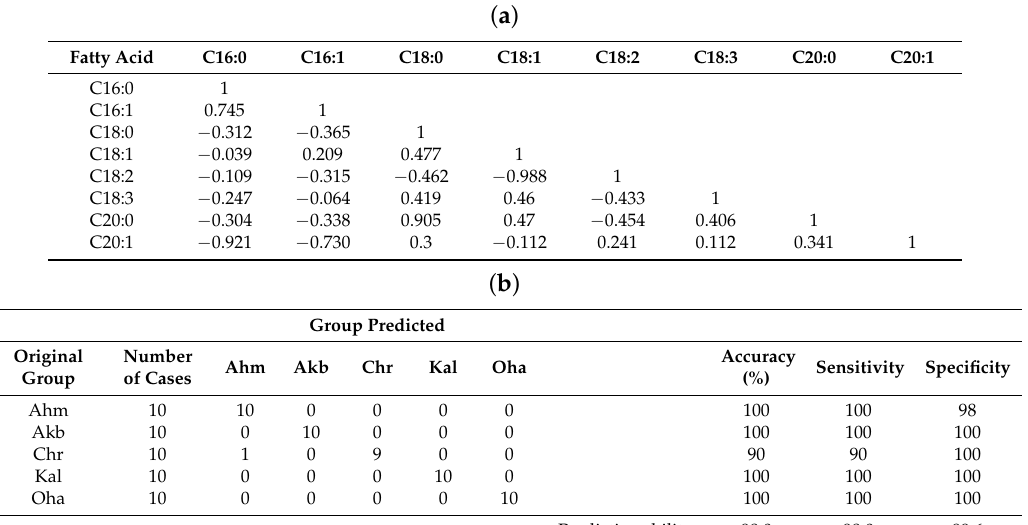
Table 3. Correlation coefficients of the fatty acid composition (%) of pistachio oils from different cultivars (a), and predicted group membership of Iranian pistachios according to their cultivars using linear discriminant analysis (LDA)